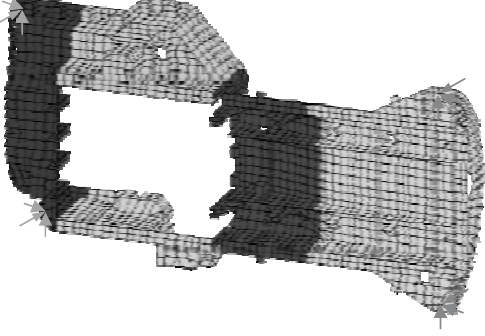
Fig. 3. Sump of a car engine, five